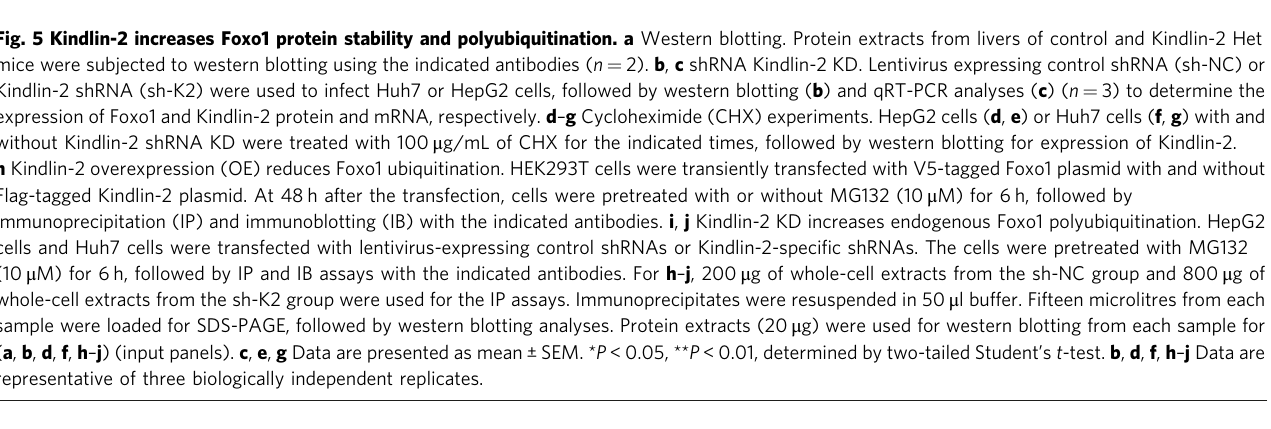
(Fig. 6i). Kindlin-2 KD increased the interaction of Skp2